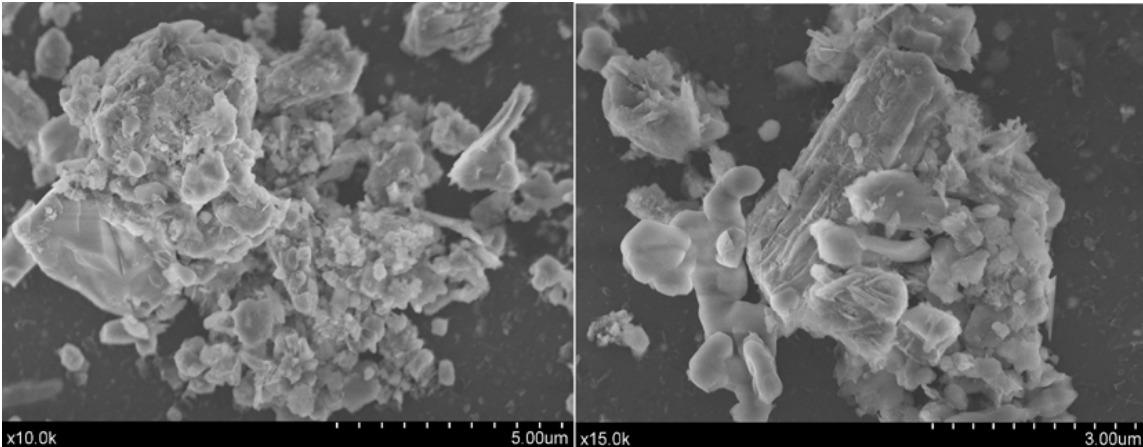
Figure 4. SEM micrographs of steel slag adsorbent at different magnitude.